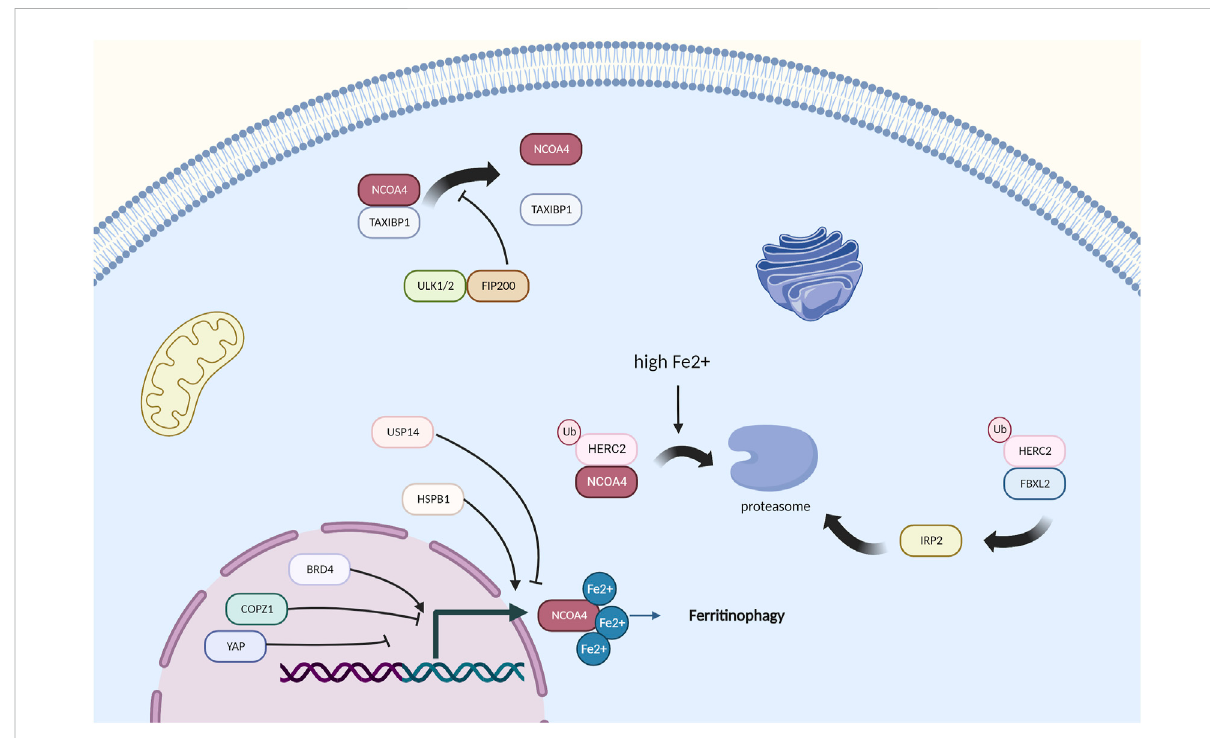
FIGURE 3 Regulators of NCOA4-mediated ferritinophagy, HERC2 and high iron pressure play a main role in the regulation of